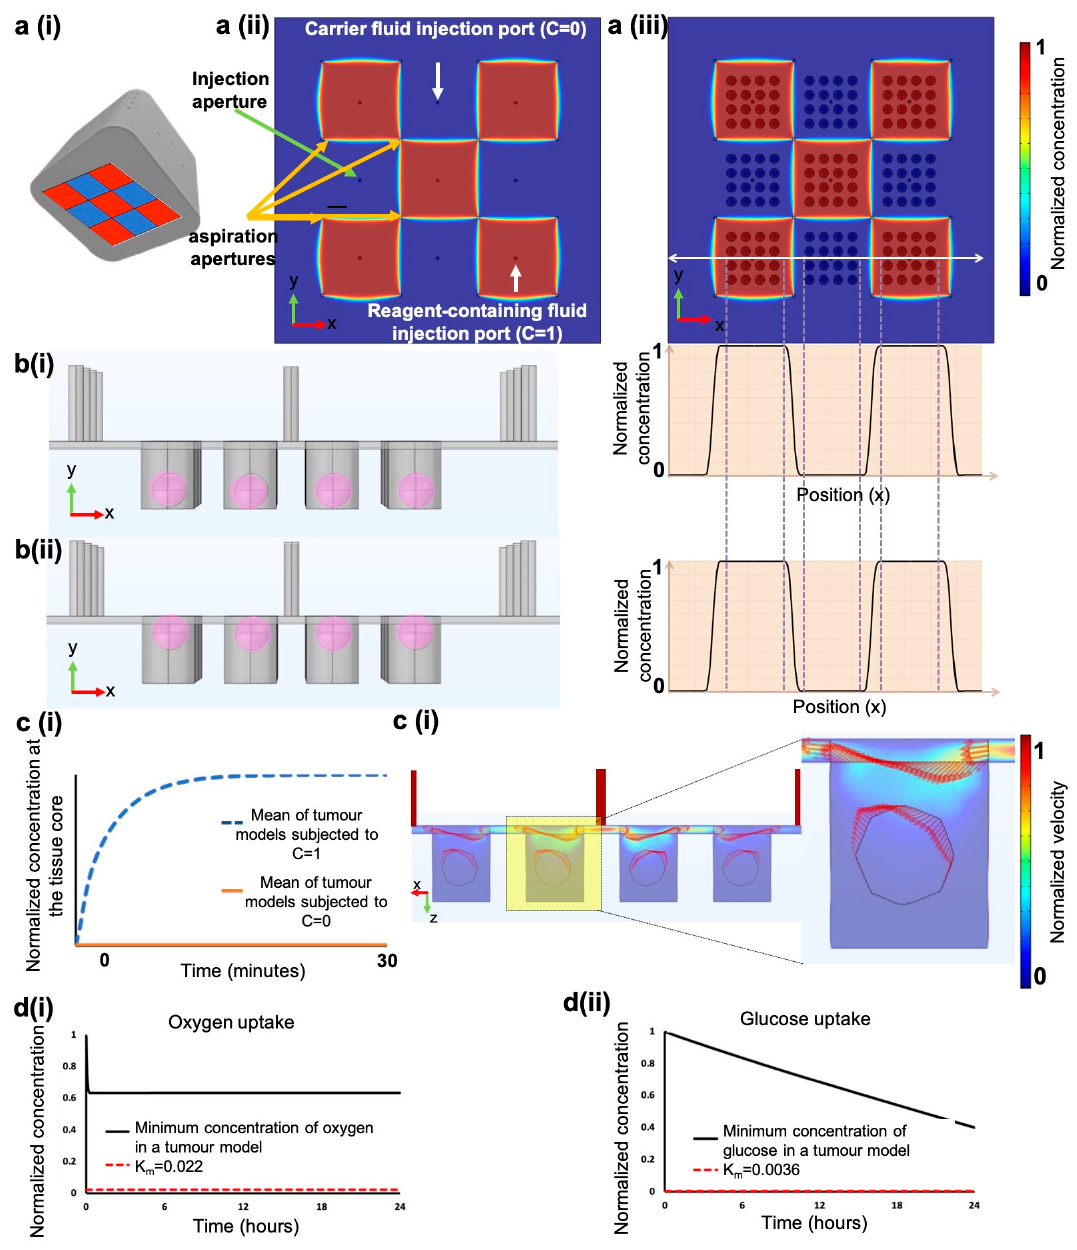
Figure 2. Numerical simulations of the PCD operation over tumour models. ( a ( i )) a schematic of the PCD and fluidic pixels modelled in the simulation, fluidic pixels formed over a flat surface ( a ( ii )) are comparable to those formed over the microwell array ( a ( iii )). ( b ) The positioning of the MDTs or spheroids in the microwells does not impact the operation of the PCD. ( c ( i )) Time required to reach a constant concentration throughout the tissue; ( c ( ii )) Arrow plots to visualize the distribution of the velocity field in the numerical model suggest the lack of free flow inside tumour models. ( d ( i )) Oxygen and ( d ( ii )) glucose consumption profile over time in tumour models cultured in the microwell array without perifusion. Tissues of up to 500 µ m in diameter can survive in microwells for over 24 h, as the oxygen and glucose concentration stays above typical K m values for cancer